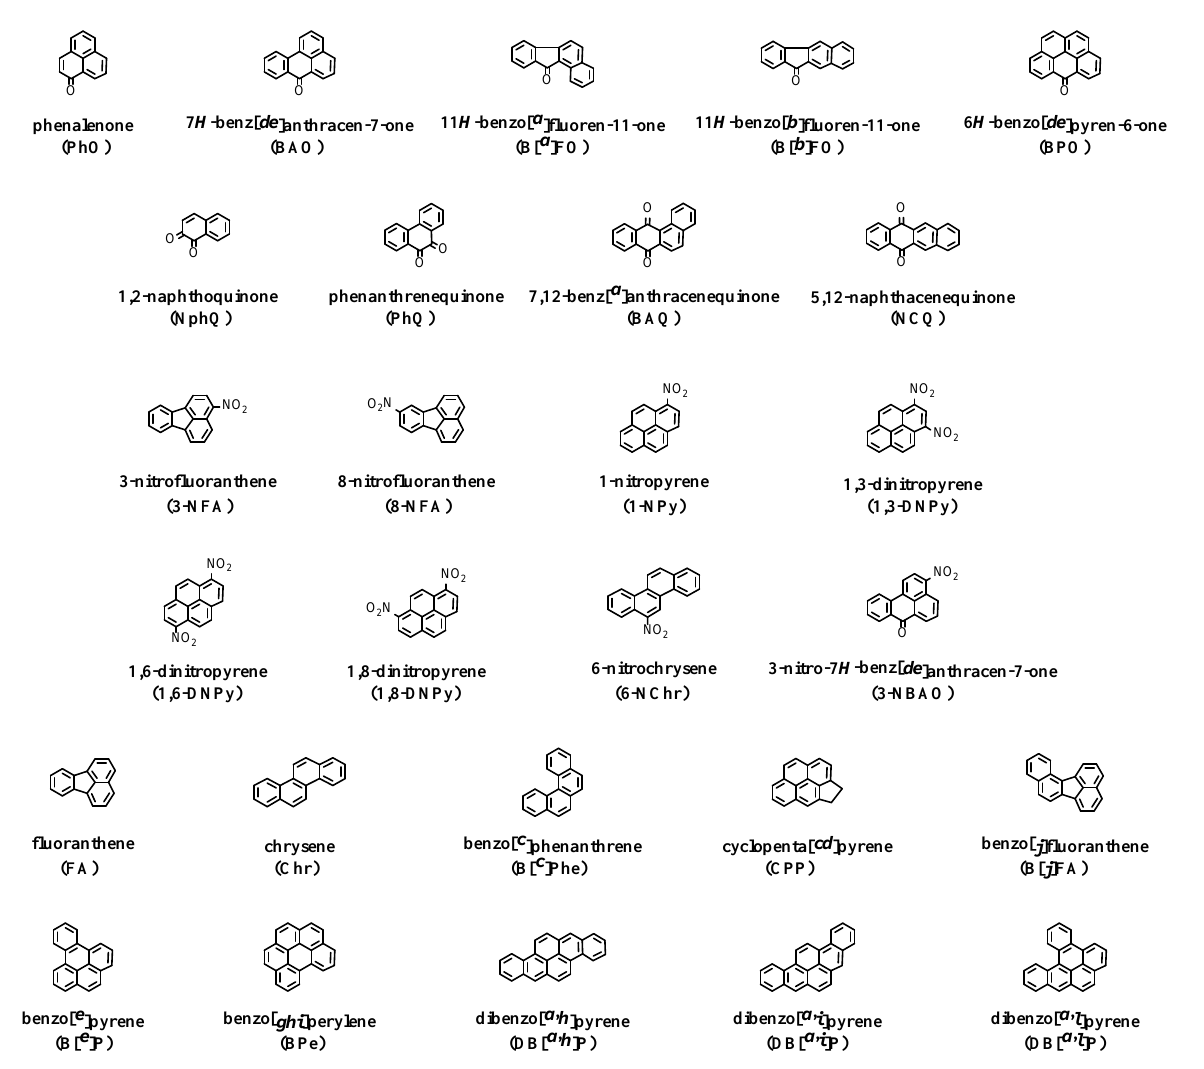
Figure 1. Chemical structures of the studied polycyclic aromatic compounds.